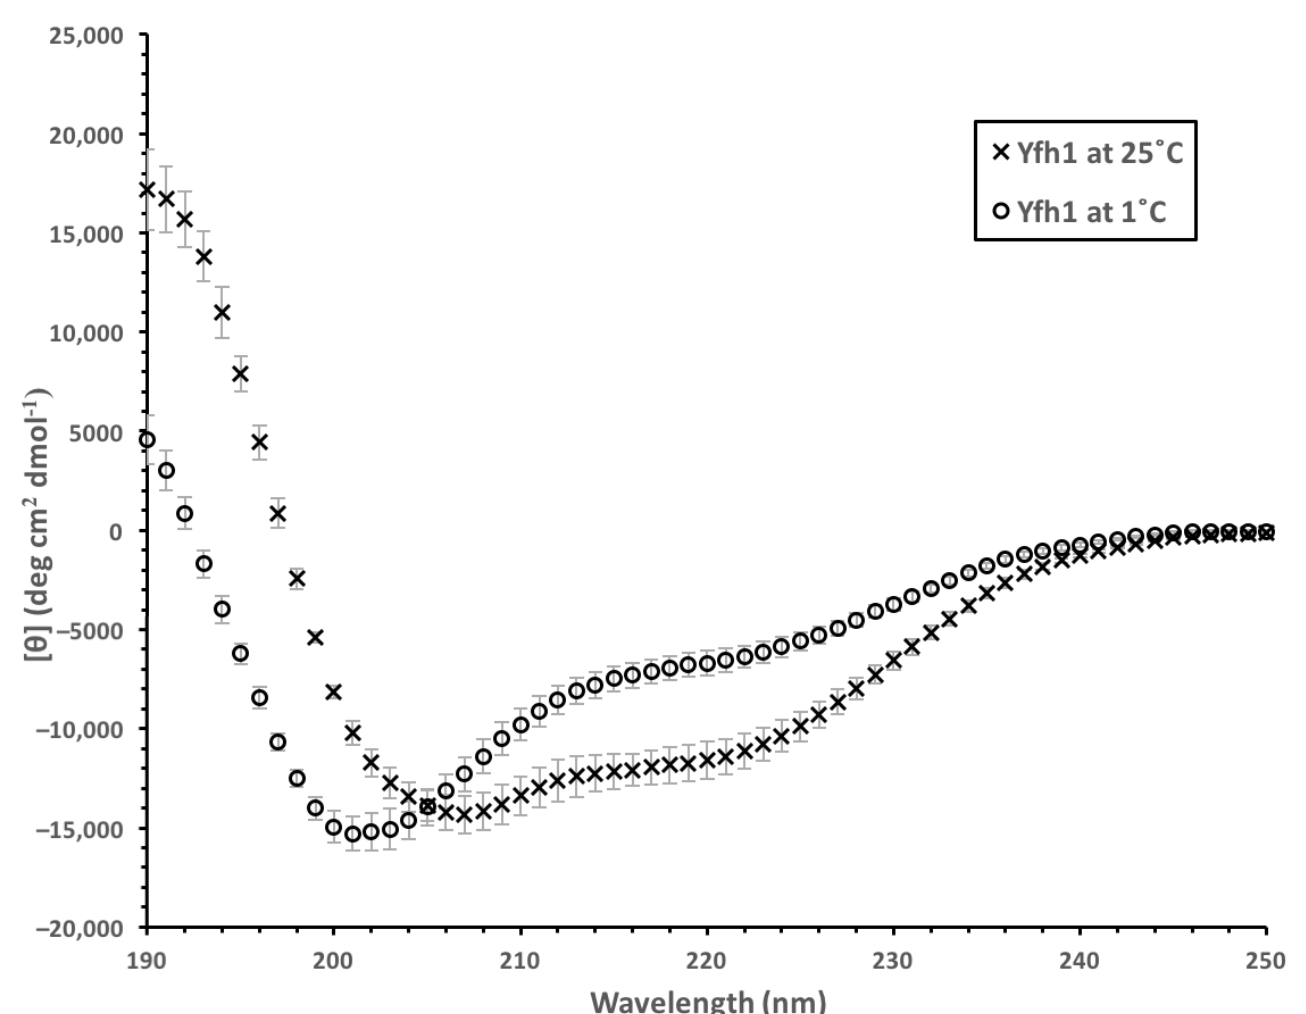
Figure 4. Spectra of Yfh1 at 25 and 1 °C . CD spectra of 10 μM Yfh1 at 25 °C and 1 °C in 10 mM Tris, pH 7.4. The spectra shown here are an average of eight replicates with error bars representing standard deviation.